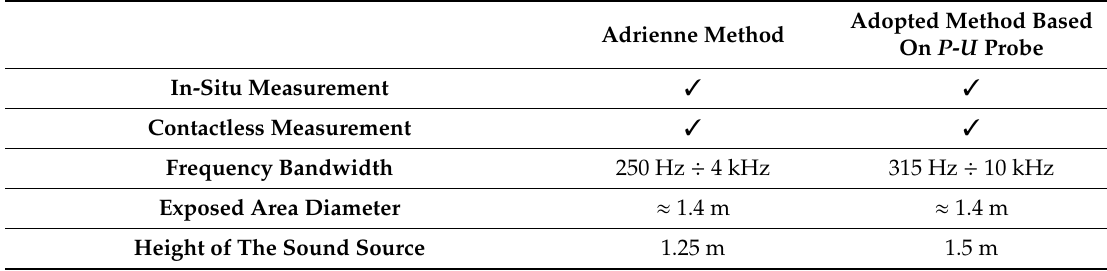
Table 1. Comparison of in-situ measurement